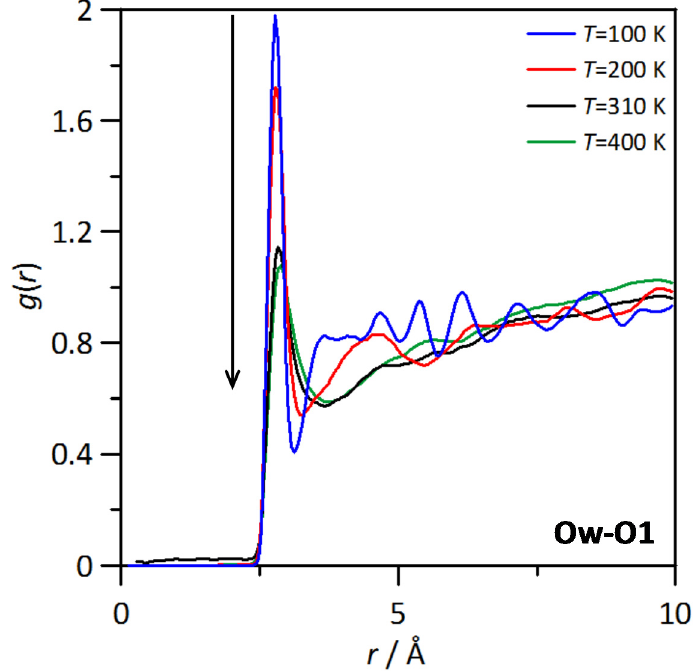
Figure 9. Site-site radial distribution functions, g ( r ), for the reported atomic pairs in ω THAL + (1- ω ) water mixture ( ω = 0.112) as a function of temperature. Atom labelling as in Figure 1.